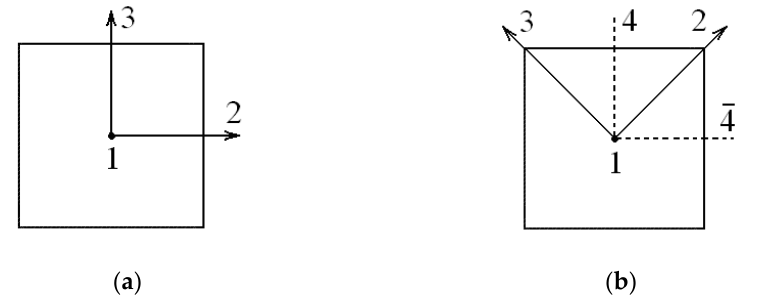
Figure 2. The schemes of samples for investigation of piezo-optic effect in LiTaO 3 crystal: ( a ) the sample of direct cuts, ( b ) the sample of the Х /45 ° -cut. The directions 1, 2, 3 correspond to the axes of the optical indicatrix X , Y , Z .